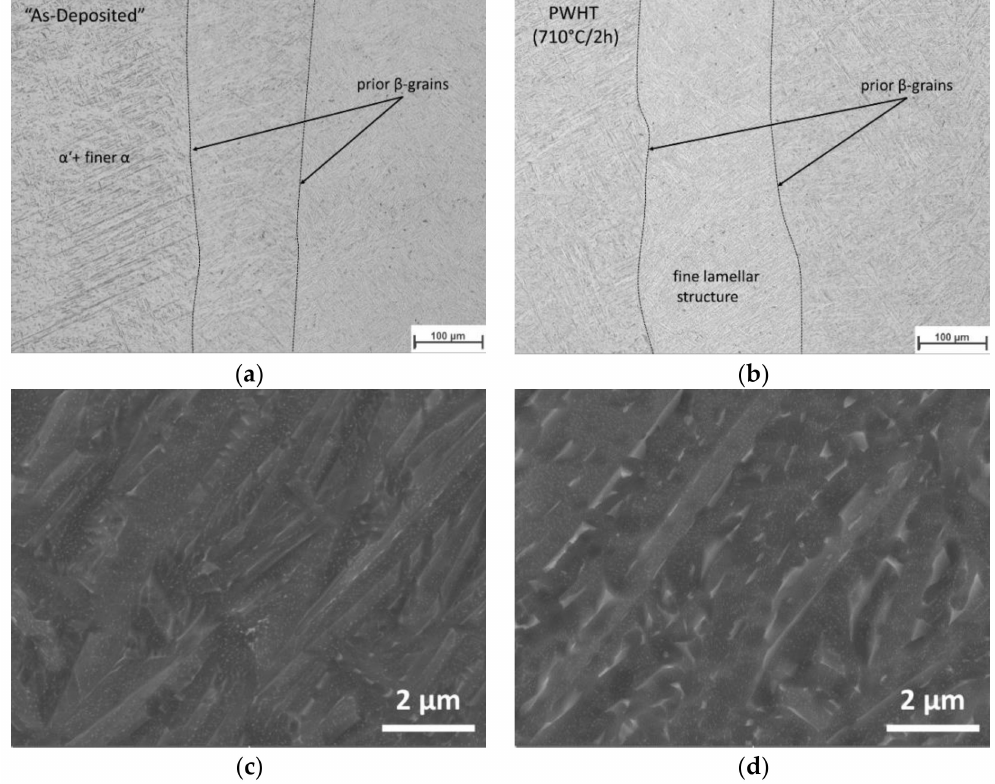
Figure 7. Microstructure of the AM block center: ( a ) as-deposited and ( b ) after PWHT condition; Detail of the microstructure by SEM investigations in ( c ) as-deposited and ( d ) after PWHT